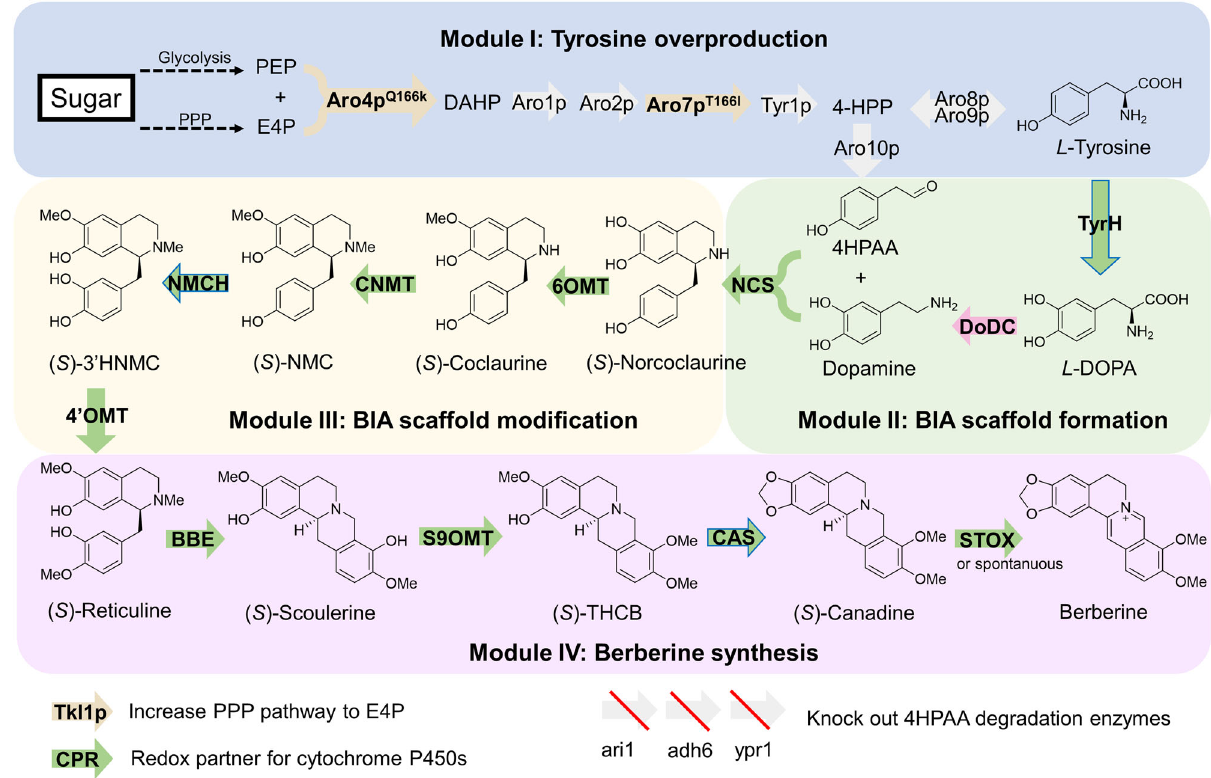
Fig. 1 Design of biosynthetic pathways for de novo production of berberine in S. cerevisiae . Block arrows indicate enzyme-catalyzed reactions. Green arrows, plant enzymes; pink arrows, bacteria enzymes; yellow arrows, overexpressed and modi fi ed yeast enzymes; gray arrows, unmodi fi ed yeast enzymes. Blue borders of arrows indicate cytochrome P450 enzymes. Arrows with red slashes indicate knocked out enzymes. Enzyme abbreviations: Aro10p, phenylpyruvate decarboxylase; Aro1p, pentafunctional arom enzyme; Aro2p, bifunctional chorismate synthase and fl avin reductase; Aro4p Q166K , mutated phospho-2-dehydro-3-deoxyheptonate aldolase with relieved tyrosine-inhibition; Aro7p T226I , mutated chorismate mutase with relieved tyrosine-inhibition; Aro8p, aromatic aminotransferase I; Aro9p, aromatic aminotransferase II; BBE, berberine bridge enzyme; CAS, canadine synthase; CNMT, coclaurine N - methyltransferase; CPR, cytochrome P450 reductase; DODC, L -DOPA decarboxylase; NCS norcoclaurine synthase, NMCH N -methylcoclaurine hydroxylase, STOX tetrahydroprotoberberine oxidase, S9OMT scoulerine 9- O -methyltransferase, Tkl1p transketolase, Tyr1p prephenate dehydrogenase, TyrH tyrosine hydroxylase, 4 ′ OMT, 3 ′ -hydroxy- N -methylcoclaurine 4 ′ - O -methyltransferase; and 6OMT norcoclaurine 6- O -methyltransferase. Compound abbreviations: DAHP 3-deoxy- D -arabino-2-heptulosonic acid 7-phosphate, E4P erythrose 4-phosphate, L -DOPA L -3,4-dihydroxyphenylalanine, NMC N - methylcoclaurine, PEP phosphoenolpyruvate, THCB tetrahydrocolumbamine, 4HPAA 4-hydroxyphenylacetaldehyde; 4-HPP 4-hydroxyphenylpyruvate. PPP pentose phosphate